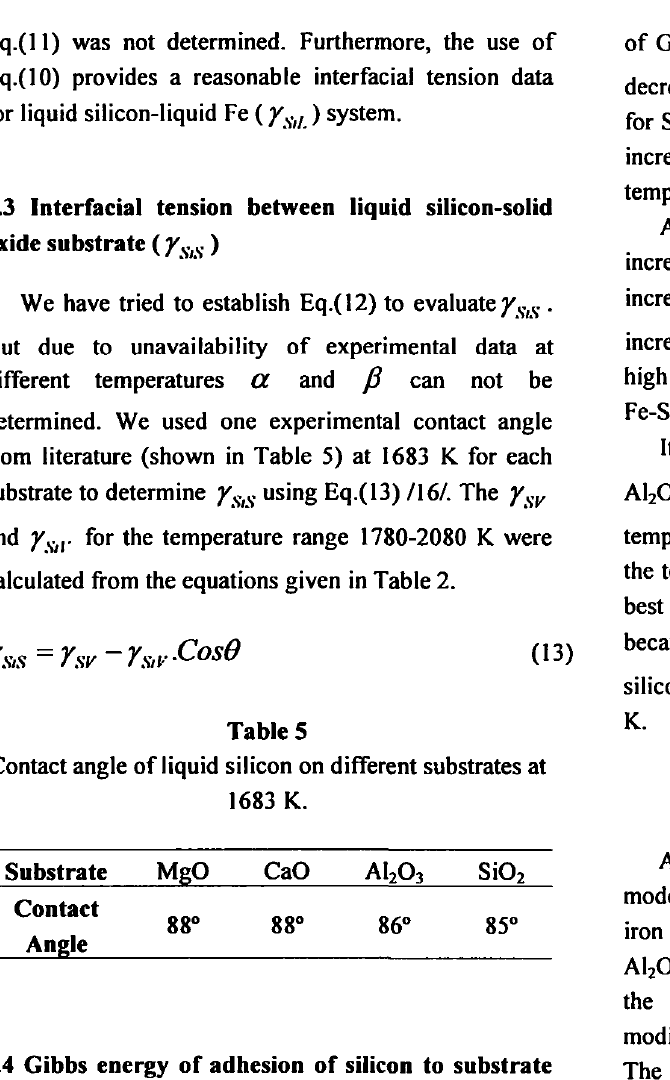
Contact angle of liquid silicon on different substrates at 1683